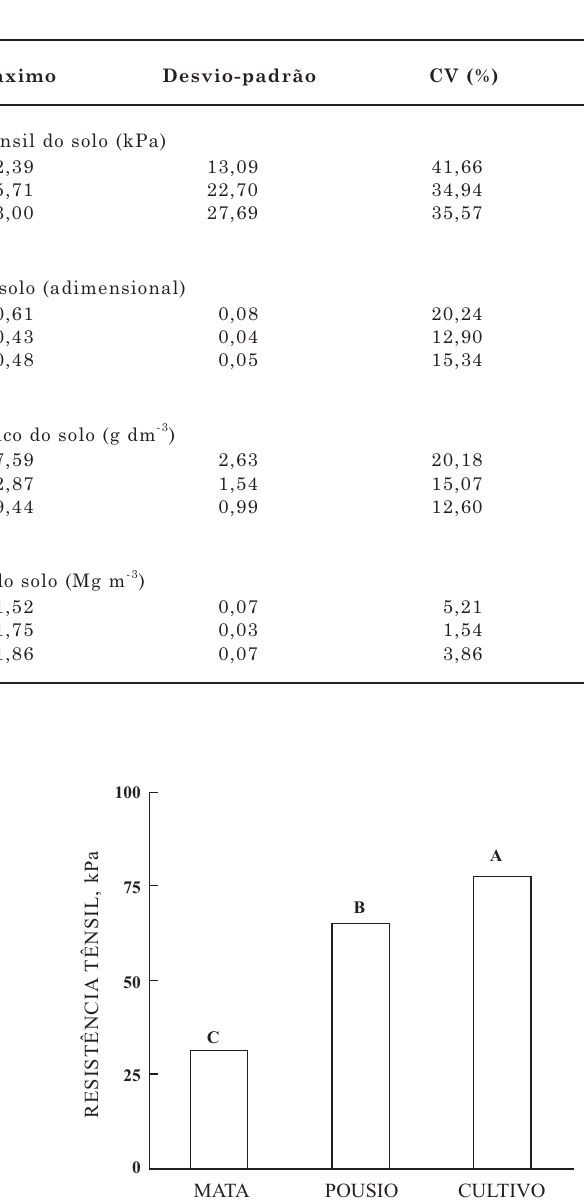
Figura 1. Valores médios de resistência tênsil dos agregados do solo para os tratamentos mata, pousio e cultivo. Médias seguidas de letras iguais entre os tratamentos não diferem entre si pelo teste de Tukey a 5